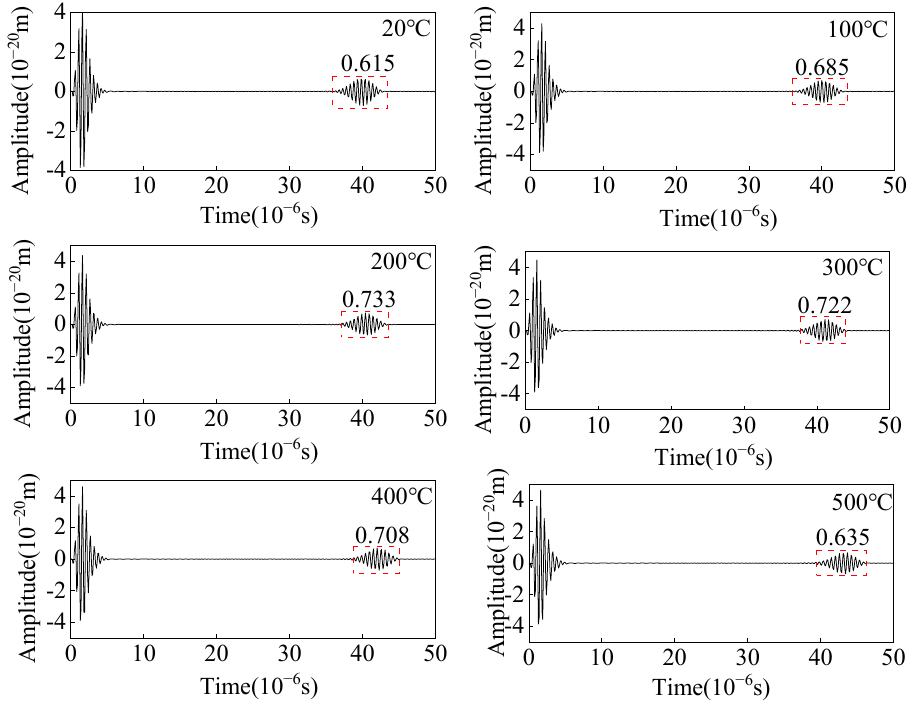
Figure 9. Influence of temperature on ( a ) radiation angle ( b ) main lobe amplitude ( c ) main lobe width ( d ) main-side lobe ratio of the angled SV wave.